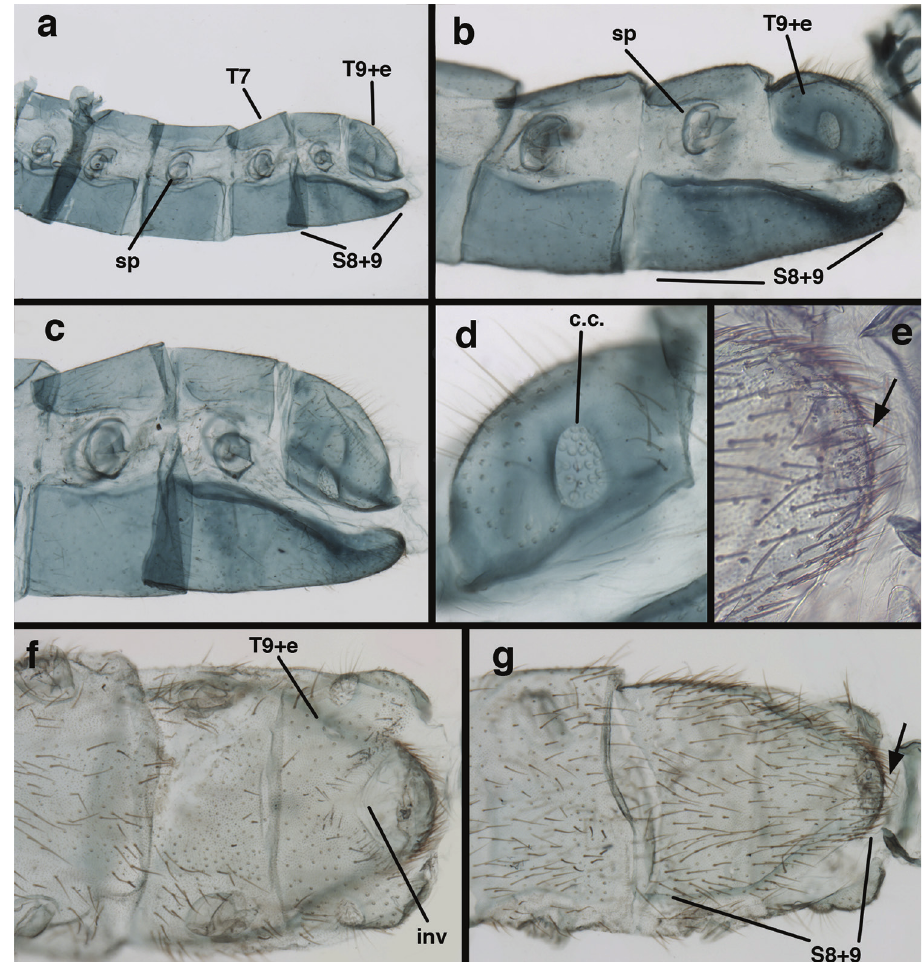
Figure 100. Ungla annulata Navás: Male abdomen, ( a ) segments A4-terminus, lateral ( b, c ) segments A7-terminus, lateral ( d ) callus cerci ( e ) tip of S9 with large, unmodified terminal setae ( f ) terminal ter- gites, dorsal [Note deep mesal invagination of T9+e.] ( g ) fused terminal sternites 8+9, ventral. c.c. callus cerci inv invaginated dorsal cleft in T9+ectoproct sp spiracle S8+9 fused eighth and ninth sternites T7 seventh tergite T9+e ninth tergite + ectoproct. Arrows indicate tip of S9 (Argentina; a, c–g : Salta, SEMC; b : Buenos Aires,